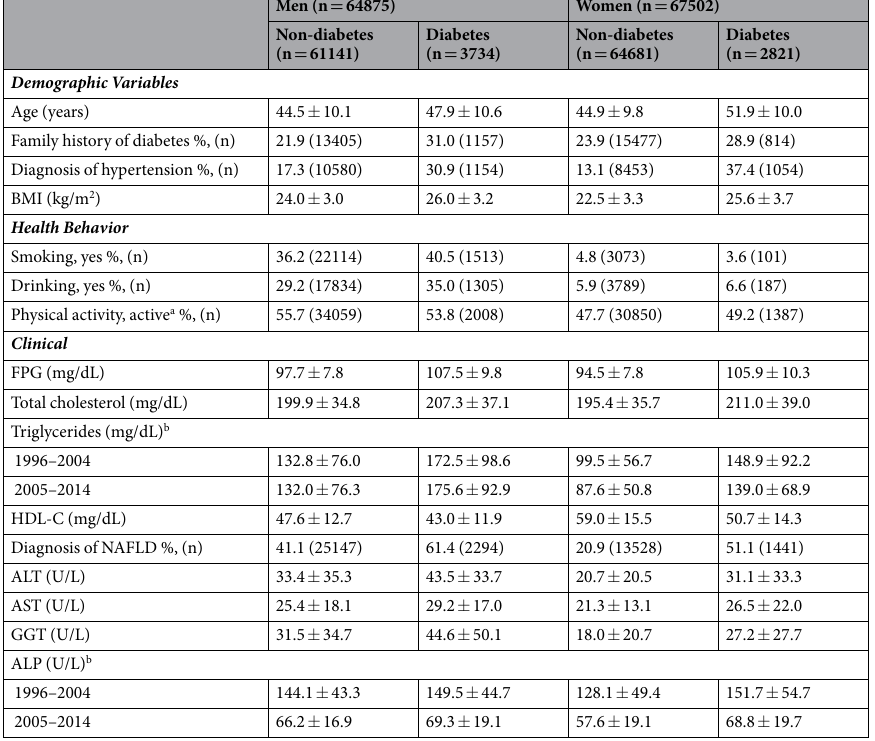
Table 1. Baseline characteristics of the participants with and without incident type 2 diabetes. The values were described as mean ± SD for a continuous variable, and as frequency (n) for a categorical variable. Abbreviations: FPG, fasting plasma glucose; HDL-C, high-density lipoprotein cholesterol; NAFLD, non alcoholic fatty acid disease; ALT, alanine transaminase; AST, aspartate transaminase; GGT, gamma-glutamyltransferase; ALP, alkaline phosphatase. a Participants with active physical activity: metabolic equivalent of task (MET)-hours per week ≥ 3.75. b Because a new analyzer was used in 2005 (using a different analysis method), the reference rage of Triglycerides and ALP are different before and after